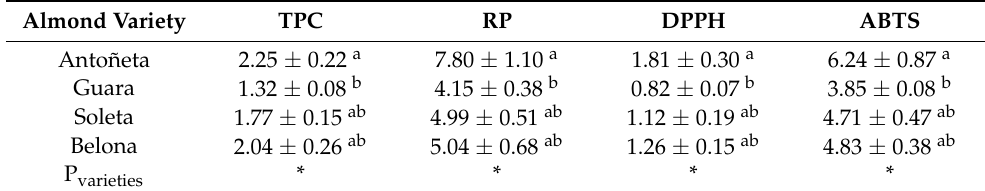
Table 1. Total phenolic content (TPC), expressed as mg GAE/g sample, and antioxidant activity as determined by reducing power (RP), DPPH radical-scavenging activity (DPPH) and ABTS radical- scavenging activity (ABTS) methods, expressed as mg TEAC/g sample. Values are reported as mean ± standard deviation (SD) of independent replicates (n =